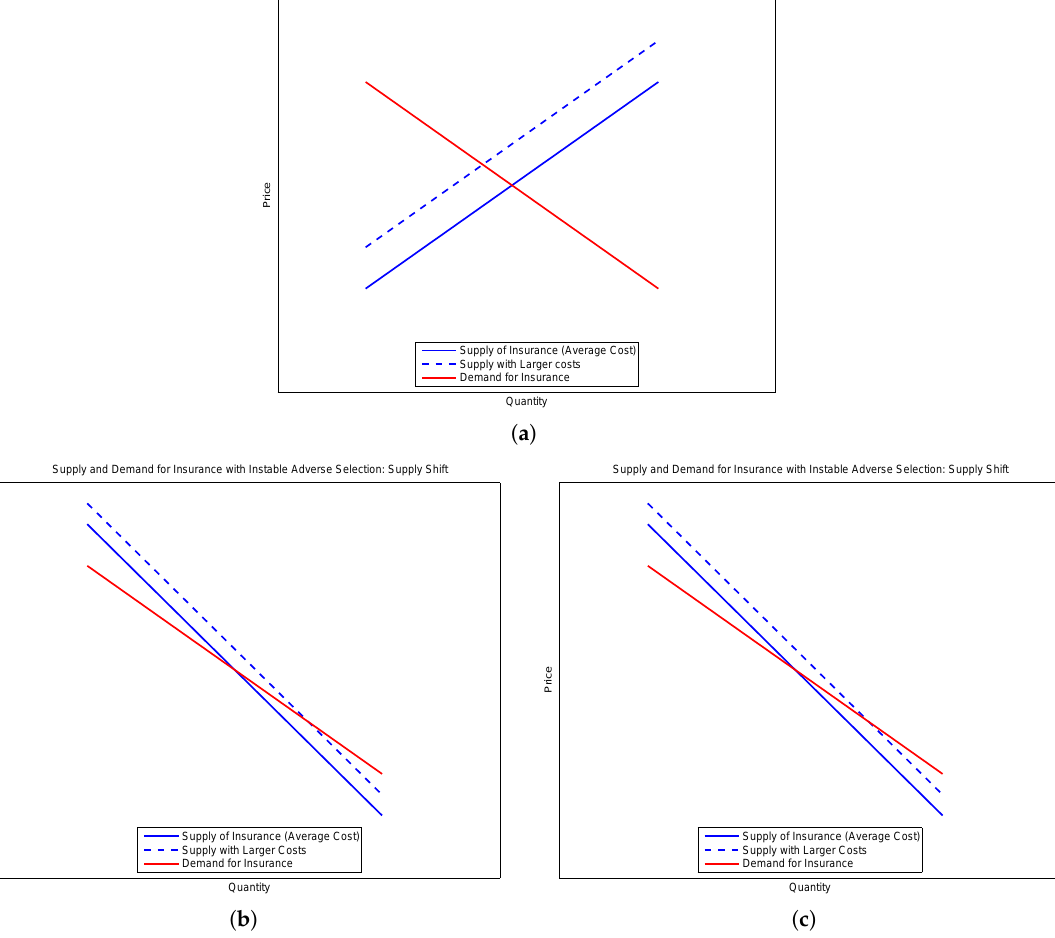
Figure 2. Supply and demand for insurance with asymmetric information and asymmetric changes to cost (i.e., no change in marginal